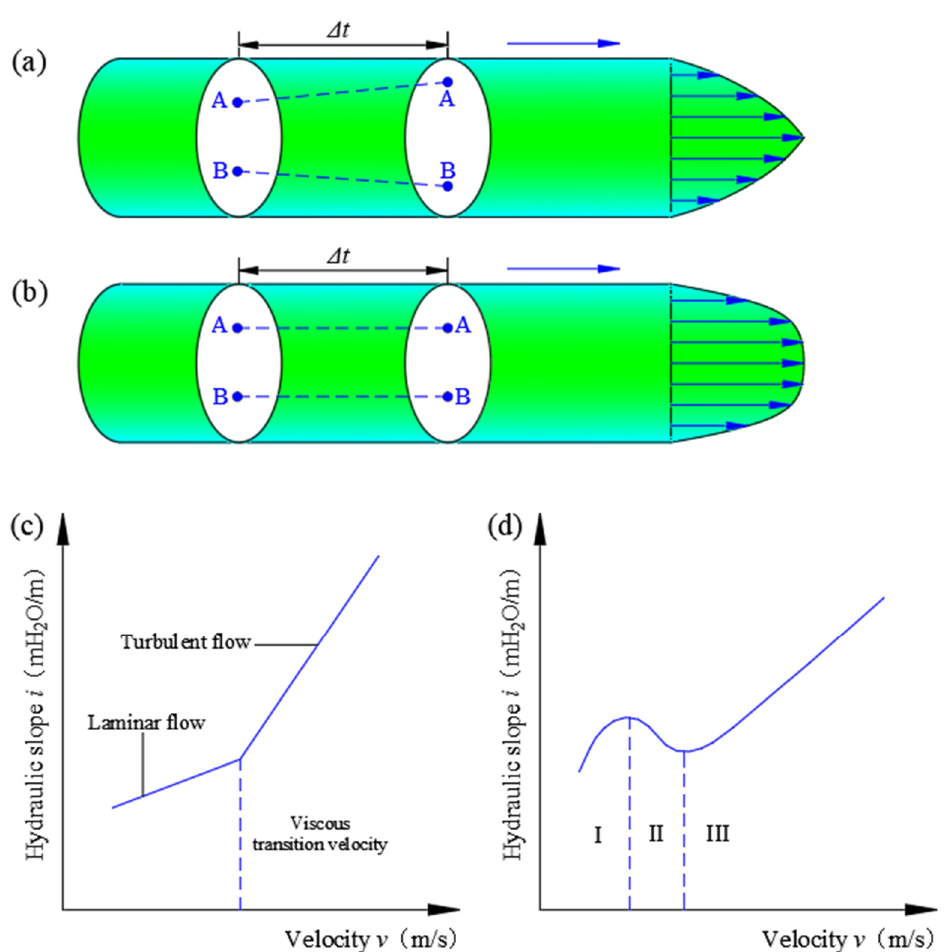
Figure 1. The relationship between velocity distribution of two-phase flow and structural flow and hydraulic slope: ( a ) the motion state and structure of two-phase flow; ( b ) the motion state and structure of the structural flow; ( c ) two-phase flow slope law; ( d ) slope law of structural flow.